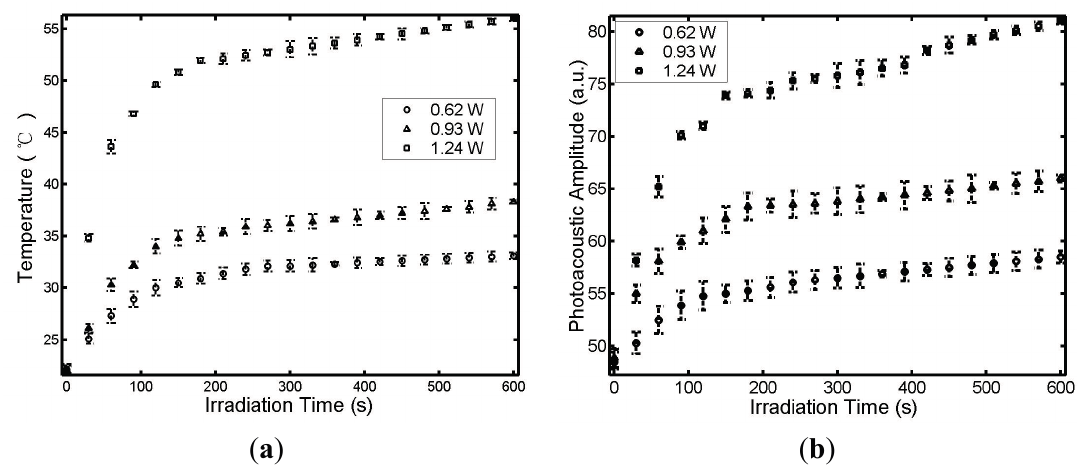
Figure 2. Temperature T measured by thermocouple ( a ) and the photoacoustic amplitude measured by the sensor ( b ), at positions B and A , respectively (see Figure 1), under interstitial laser irradiation of different powers.